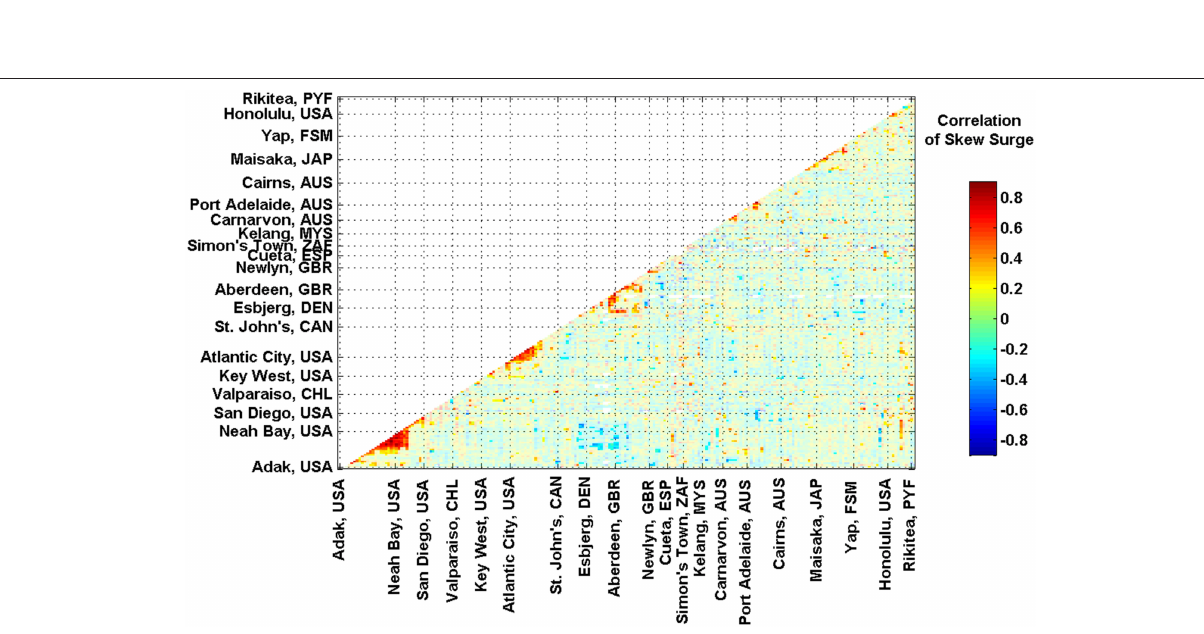
FIGURE 8 | Correlation between each site. Each site is plotted along an imaginary coastline running from Alaska down the west and up the east coast of the America, across to the Atlantic to Norway, down through Europe around Africa, around the Indian Ocean, up the western Pacific Ocean and then across the Pacific Islands to the east. Sites with correlations at the 66% level are shown as bold